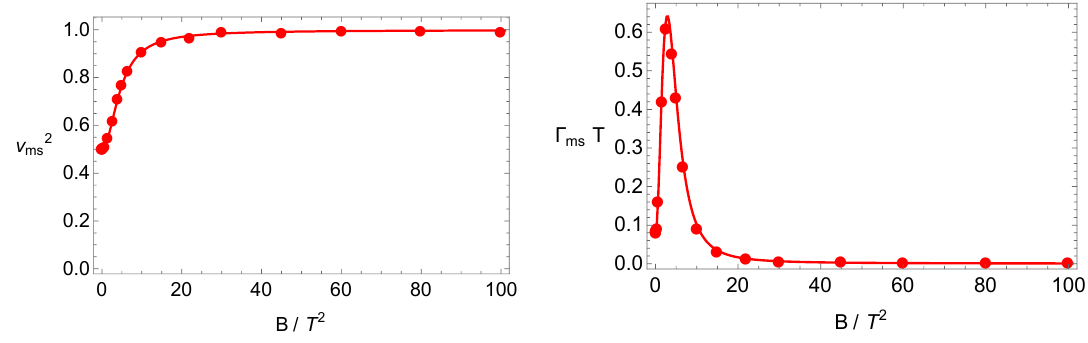
Figure 9 . Speed and attenuation constant of magnetosonic waves ( v ms , Γ ms ) at µ = 0 .